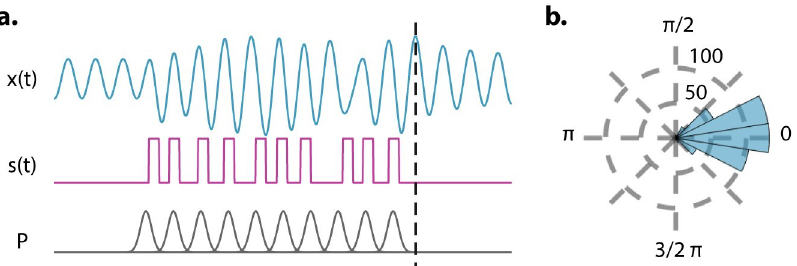
Fig 3. An oscillator can handle some irregularity. (a) The output of the Stuart–Landau model (x(t) shown in blue) in response to an example quasi-rhythmic stimulus (s(t) in magenta) that was drawn from Gaussian distributions whose means are centered in a rhythmic fashion (P in gray). Gaussian distributions have a standard deviation of 20% of expected time between tones creating substantial deviations from rhythmicity. The dashed black line shows where the mean of the next Gaussian distribution would be and therefore the expected location of the next tone if there were one. It lines up well with the peak of the oscillator. (b) A histogram of the phase extracted at the dashed line in panel a over 500 different stimuli. Phase clustering suggests that the oscillator phase contains information regarding timing of expected tones. Simulation parameters are ω = 2 π 4, λ = 1, γ = 1, k = 10, and s(t) is made up of 100-ms square steps nat with each onset drawn from a distribution in P. P is a set of Gaussians with μ = 0.25a, where a is {0, 1, 2, ... , 9} and σ =